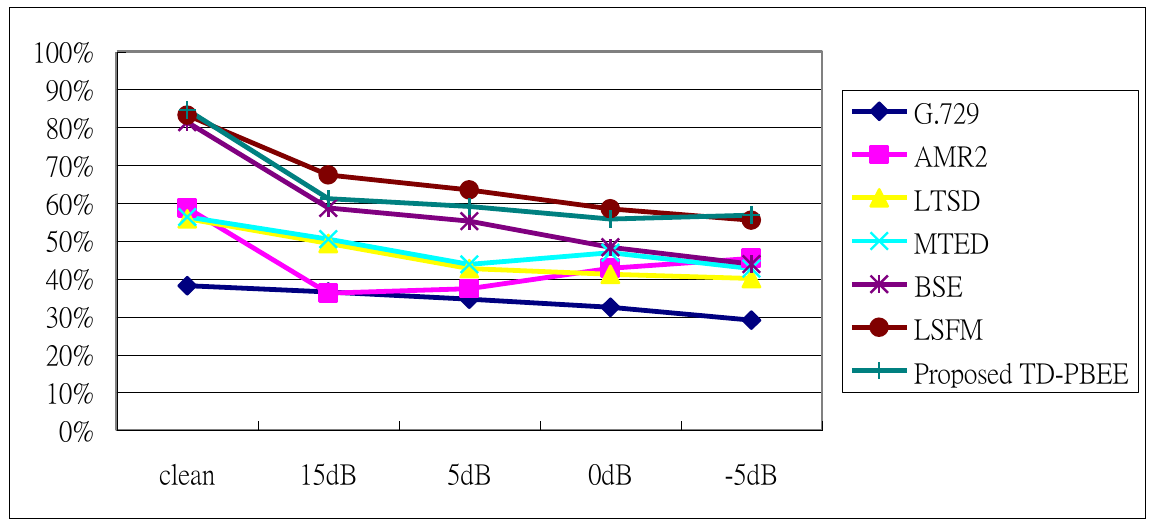
Figure 9. Non-speech hit rate (HR0) from clean to 5 dB under the four types of noise.